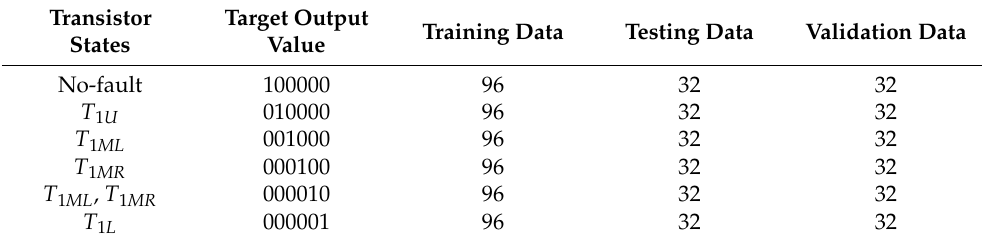
Table 2. MLP training, testing, and validation